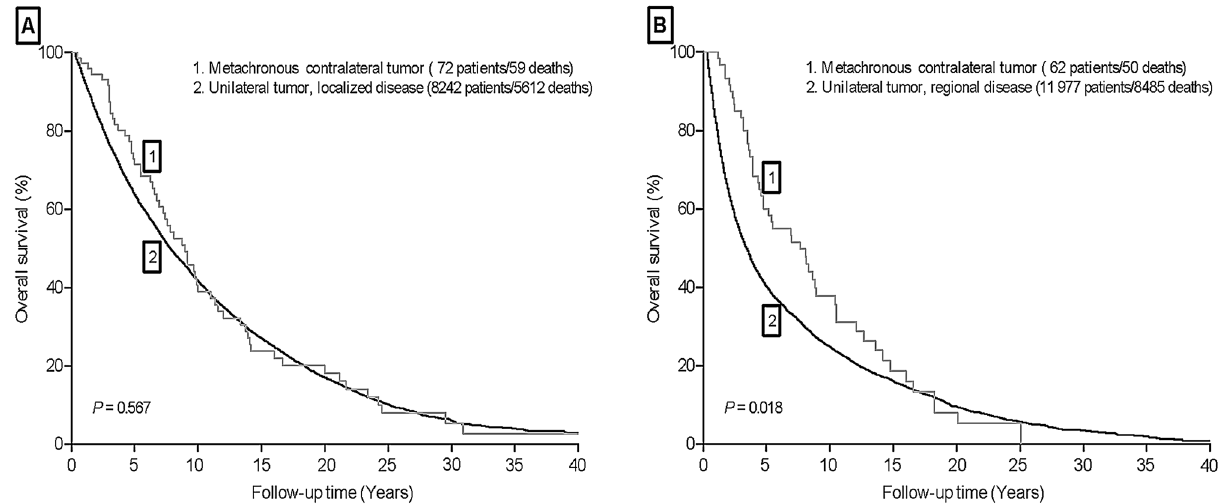
Figure. 2. Overall survival of patients who initially presented with unilateral or metachronous contralateral upper tract urothelial carcinomas (UTUC), stratified by extent of the disease at diagnosis.